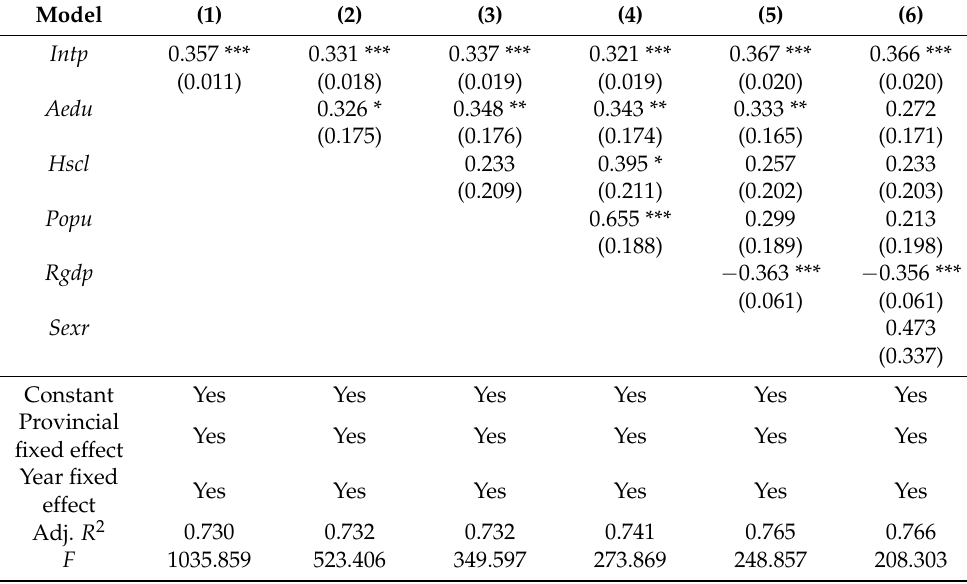
Table 8. Estimated results of IPR on the CDRs ( N = 372).